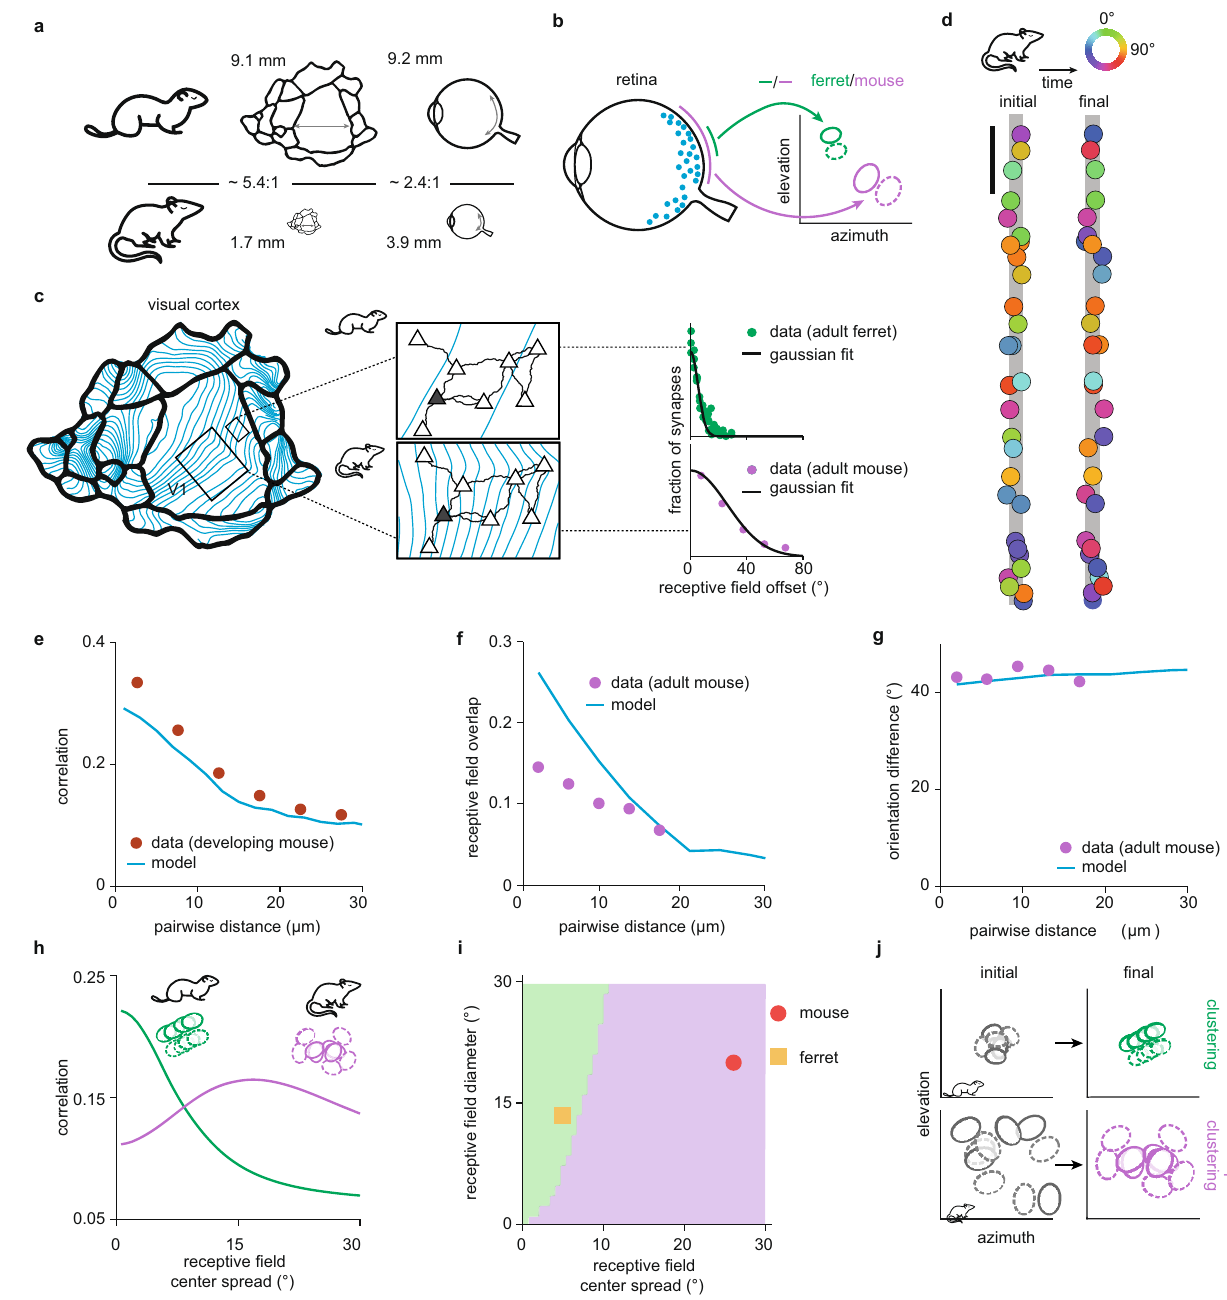
neurotrophin-inspired model for clustering supports the emer- gence of local synaptic organization in the ferret cortex.